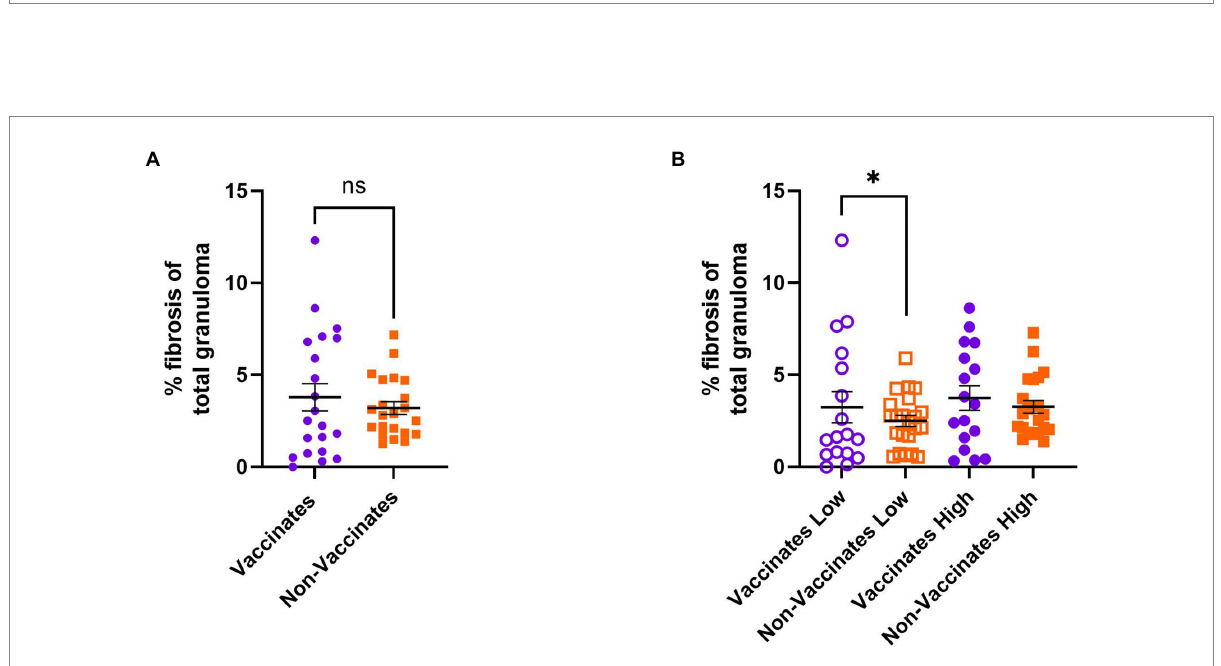
FIGURE 6 Percentage of granuloma area comprised of fibrosis as measured using Masson’s trichrome staining in BCG-vaccinated and non-vaccinated cattle infected with M. bovis. Values are broken down by vaccination group (A) and by vaccination group and grade (B) . Each dot represents one animal and its mediastinal and tracheobronchial lymph nodes. Values are presented as means ± SEM. (* = p value 0.0344, ns = not